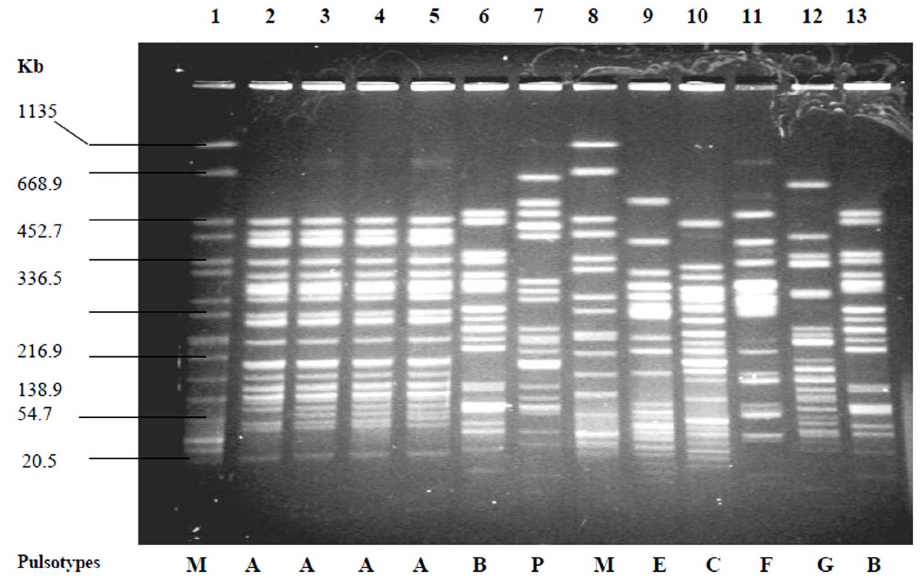
Figure 1. PFGE banding patterns of Xba I-digested chromosomal DNA of representative ESBL-producing E.coli isolates. Lane 1, Salmonella enterica serovar Braenderup (H9812) (marker); Lanes 2-5, PFGE type A; Lane 6, PFGE type B; Lane 7, PFGE type P; Lane 8, Salmonella enterica serovar Braenderup (H9812) (marker); Lane 9, PFGE type E; Lane 10, PFGE type C; Lane 11, PFGE type F; Lane 12, PFGE type G; Lane 13, PFGE type B. Four isolates belonged to PFGE pattern A were isolated from UTI patients attending SMCH